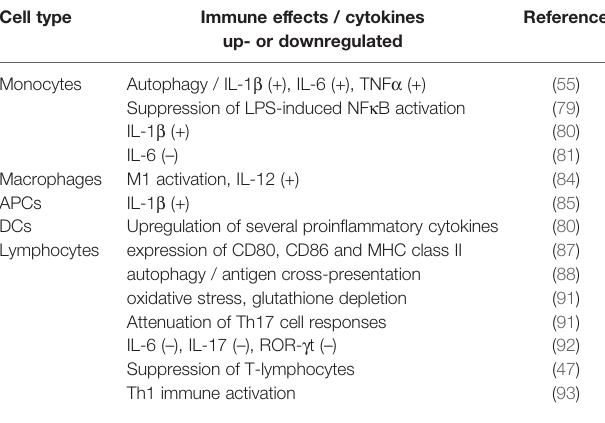
TABLE 2 | IONP-derived immune effects and up-/downregulated cytokines of the studies reviewed in this articles. Cell